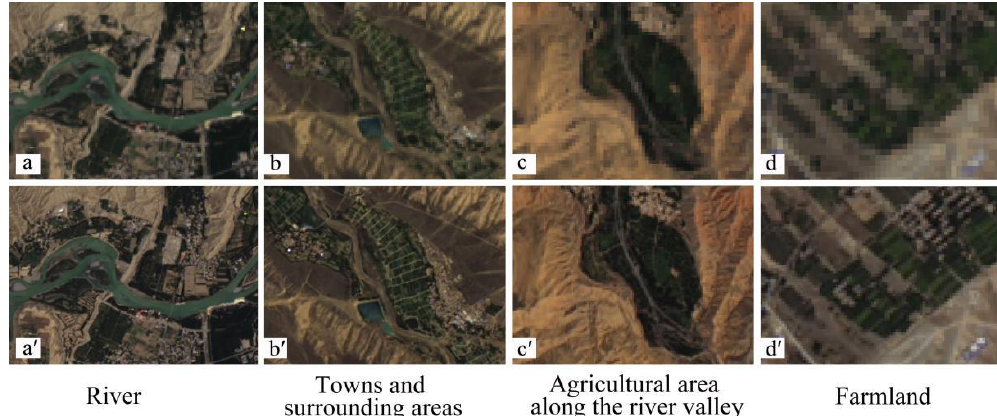
(cid:48) – d (cid:48) ) are after